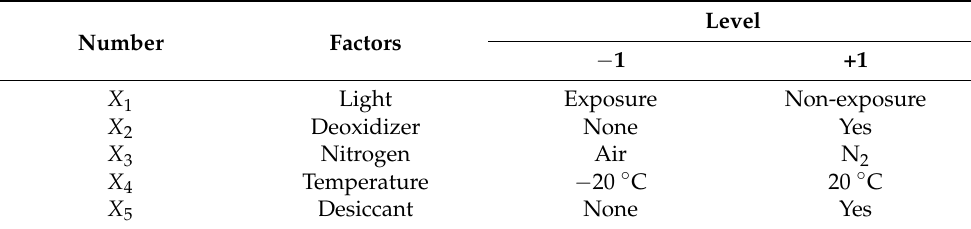
Table 5. Plackett–Burman factor level